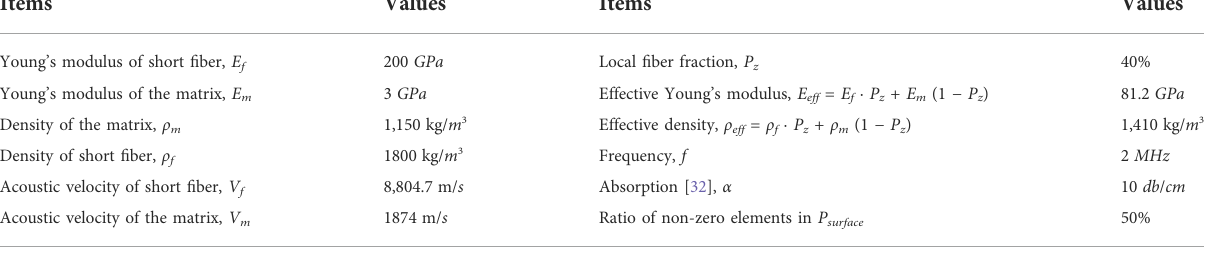
TABLE 1 Material parameters. Items